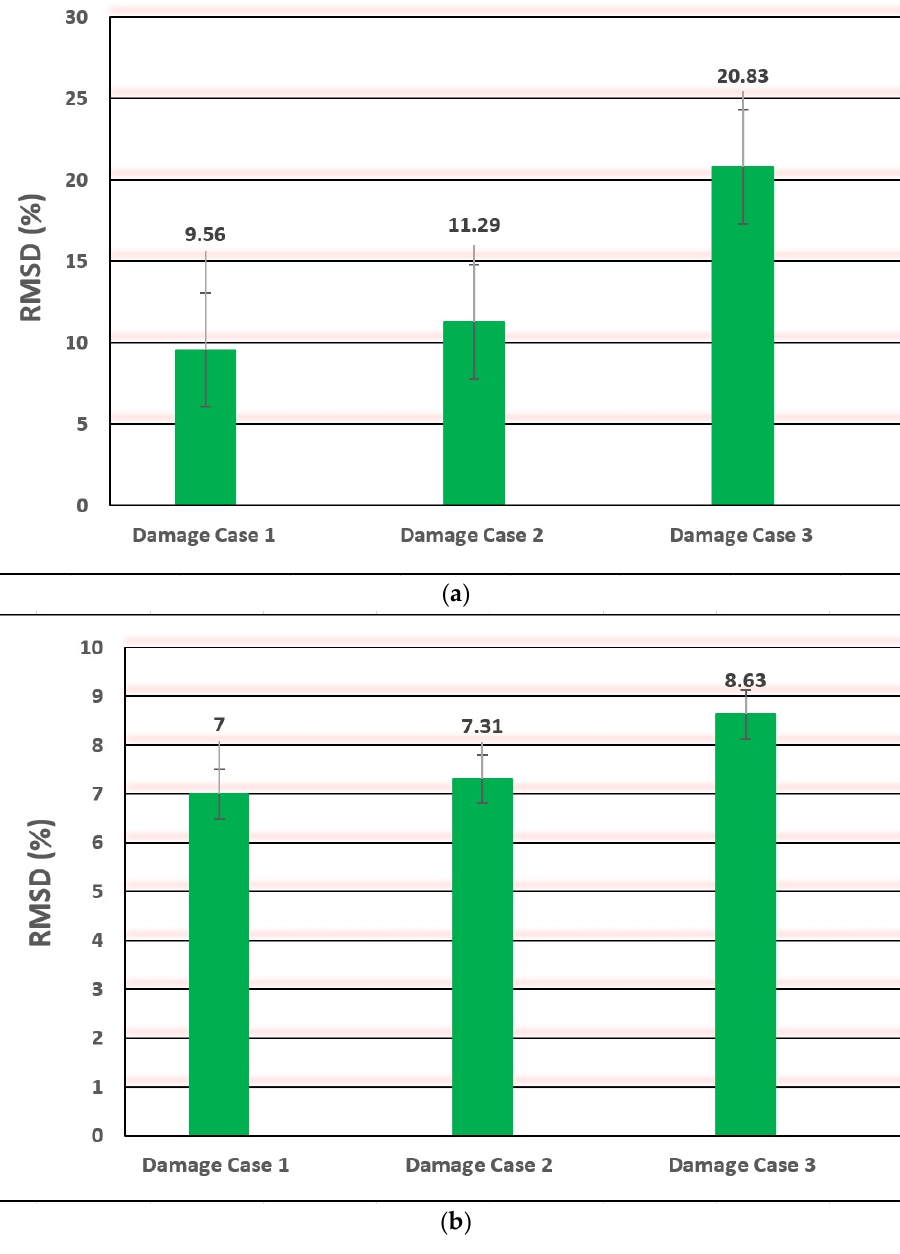
Figure 10. RMSD for damage cases of specimens ( a ) welded steel plates (B03) and ( b ) T-type welded steel plates (I13).